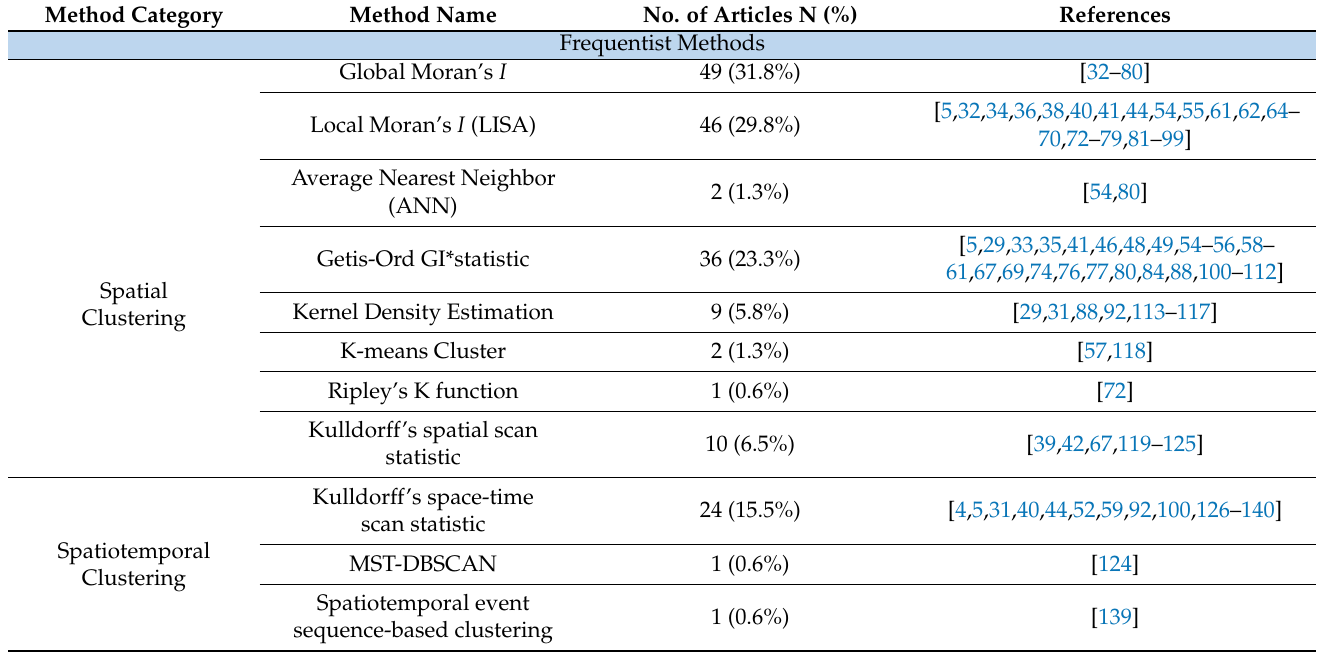
Table 1. Spatial methods used for clustering and risk factor identification in COVID-19